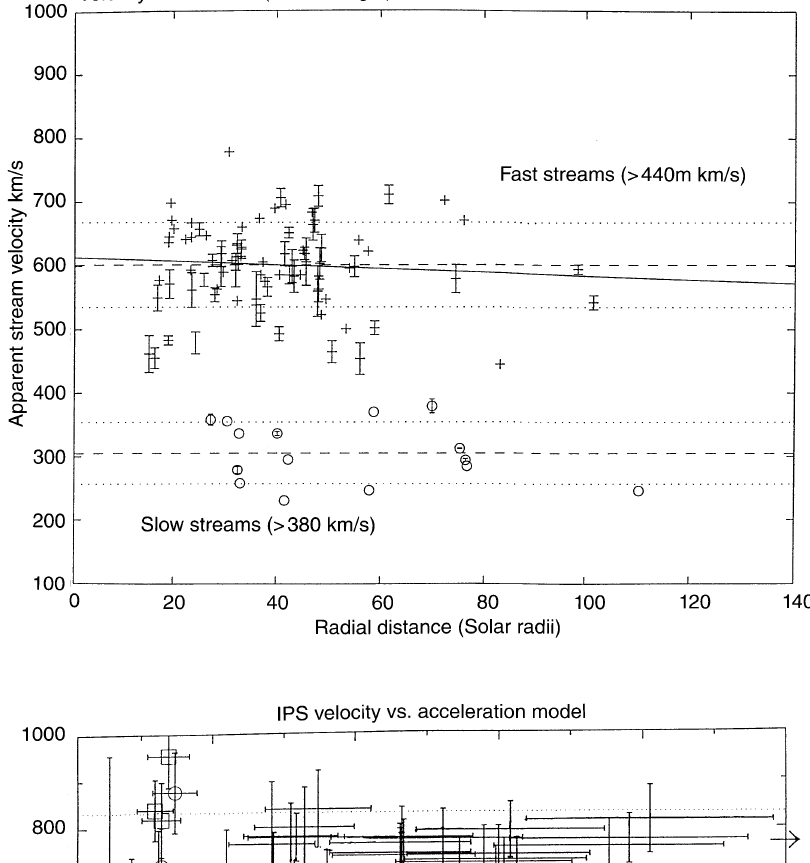
Fig. 6. Variation of velocity of high-latitude fast streams determined from EISCAT and VLBA measurements (Grall et al ., 1996). The EISCAT measurements (from the southern polar hole between April and September 1994) are marked with crossed bars , while VLBA measurements are marked with circles (south polar hole measurements) or squares (measure- ments from the northern polar hole). In all cases the vertical bar represents the 90% confidence limit for the velocity and the horizontal bar indicates the distance range over which the measurement is averaged. The points inside 10 R (cid:120) are derived from SPARTAN 201-01 white-light measurements (Fisher and Guhathakurta, 1994; Habbal et al .,